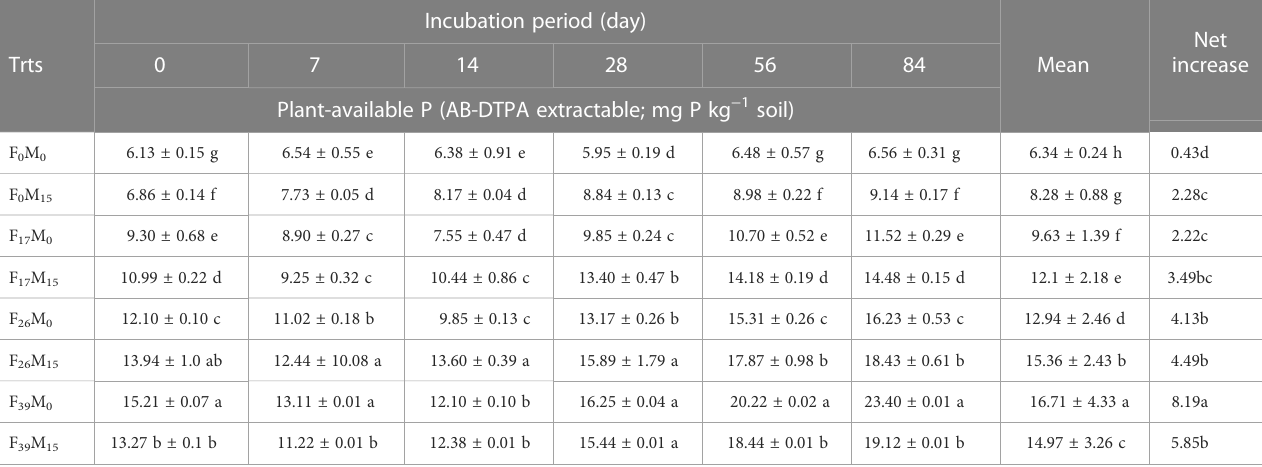
TABLE 2 Laboratory incubation: effect of fertilizer phosphorus (P) and farmyard manure (FYM) applications on soil AB-DTPA extractable P transformation during 12 weeks of incubation.